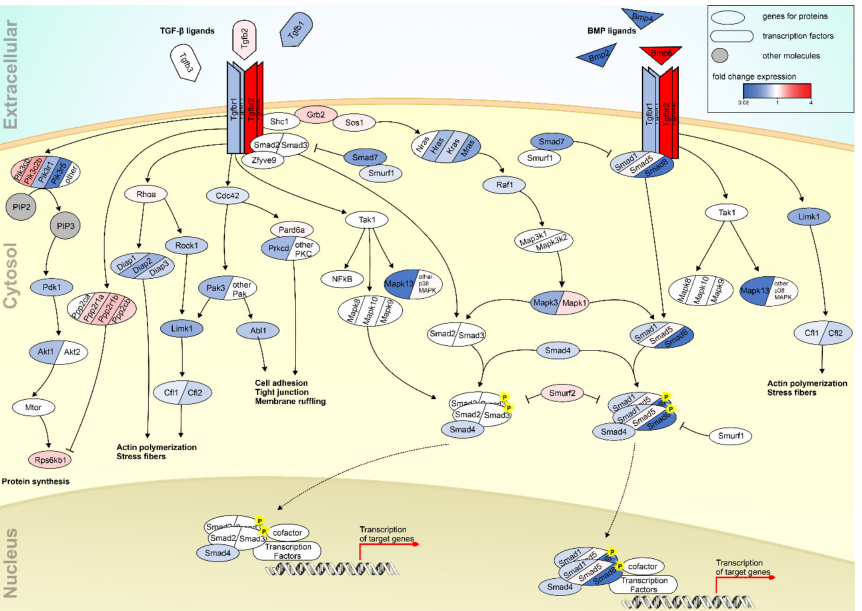
Figure 3. Differential gene expression of TGF- β receptor signaling pathway proteins in TPC1- deficient MEF cells compared with wildtype cells. Color code indicates changes in expression. Up- and downregulated genes are displayed in red and blue, respectively. Genes that show no significant differential expression (q > 0.05) in RNA-seq are shown in white (fold change = 1). Figure was adopted from an illustration and by courtesy of Cell Signaling Technology,